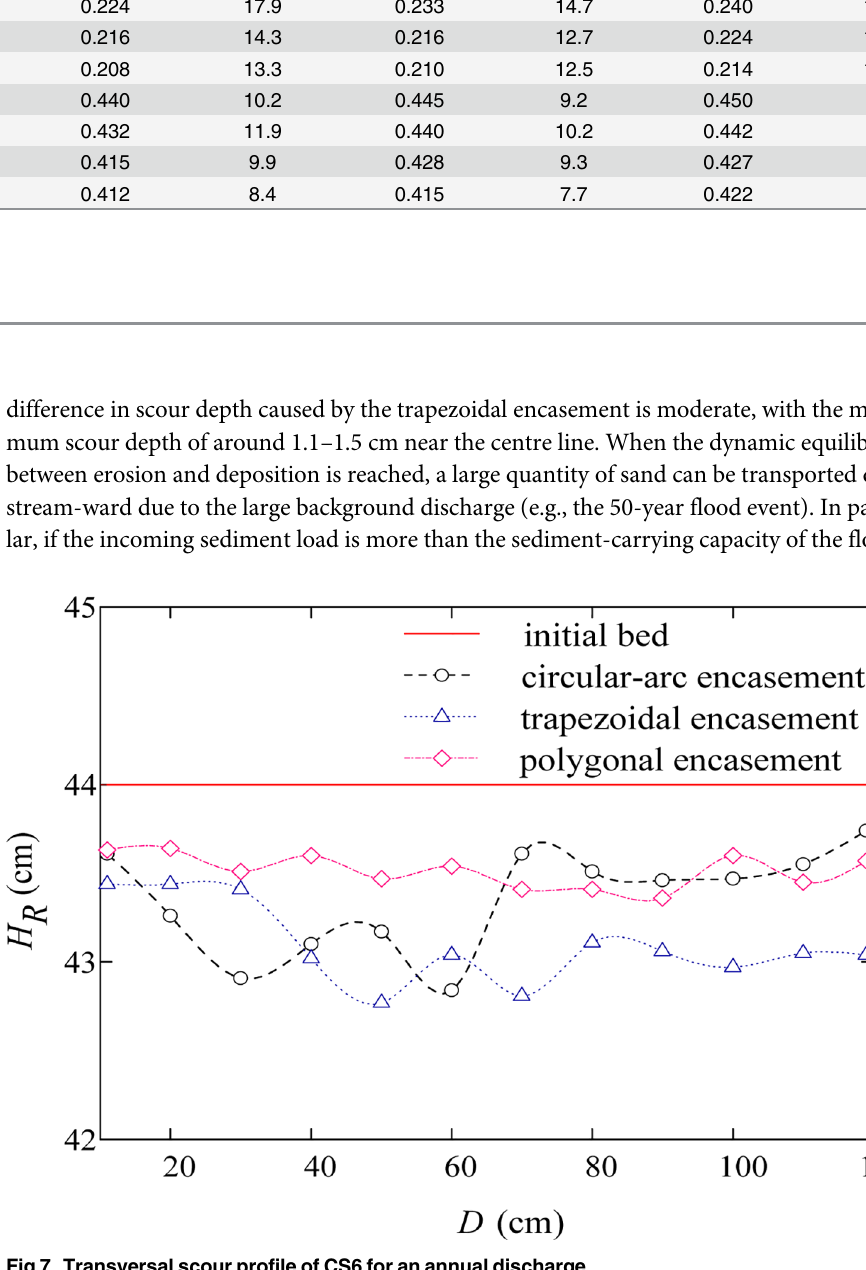
Fig 7. Transversal scour profile of CS6 for an annual